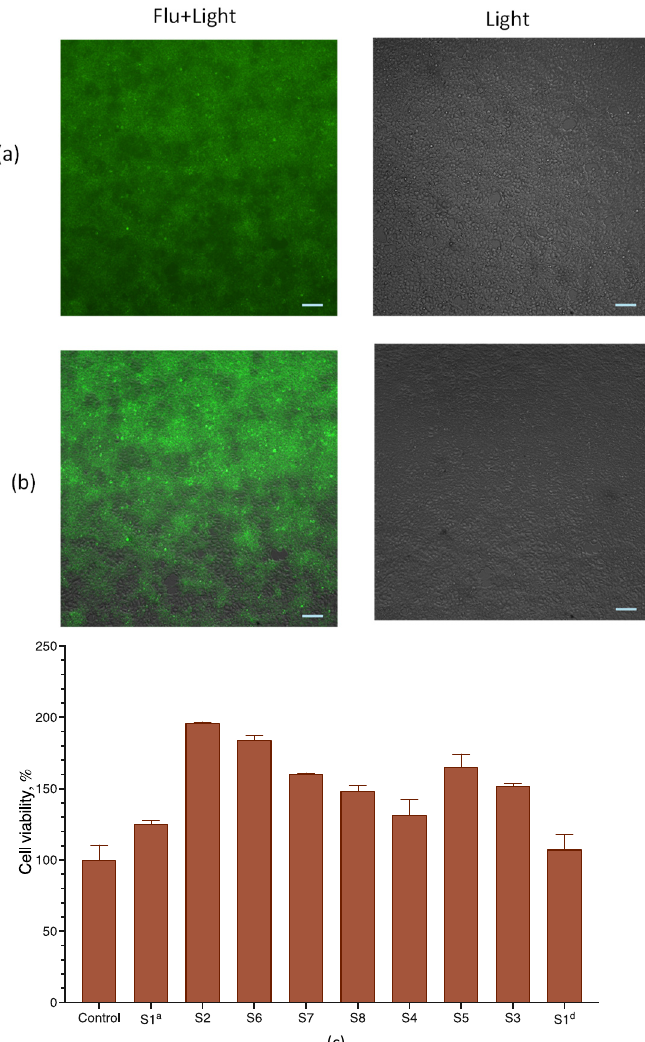
Figure 5. Viability assessment of HEK 293T cells. Microscopy of lipoplexes prepared from